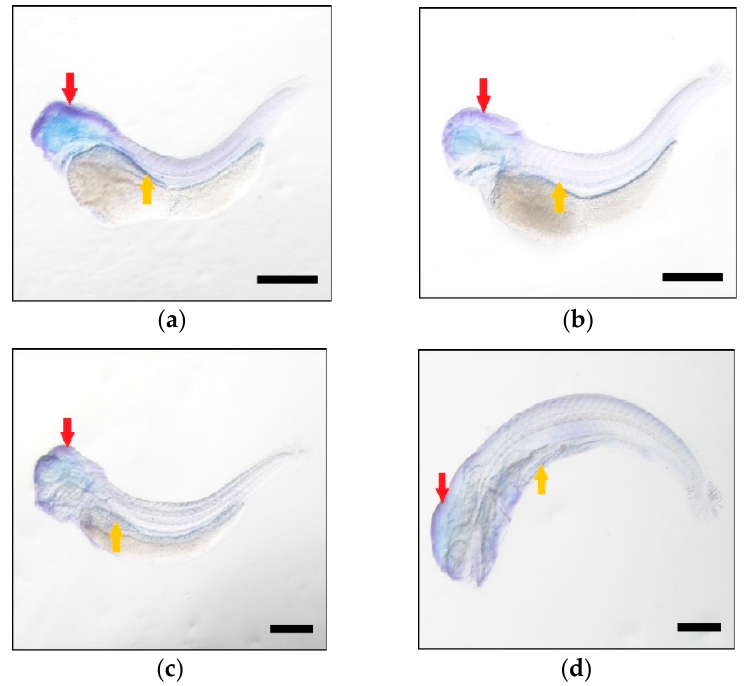
Figure 5. The tissue expressions of elovl5b during common carp larvae development detected using WISH at 48 hpf ( a ), 72 hpf ( b ), 96 hpf ( c ) and 120 hpf ( d ). Larvae were hybridized with the probes and the blue dye represented the expression signal. Black scale bars: 500 μ m. The red arrow indicated the head region and the duct was marked with the yellow arrow.